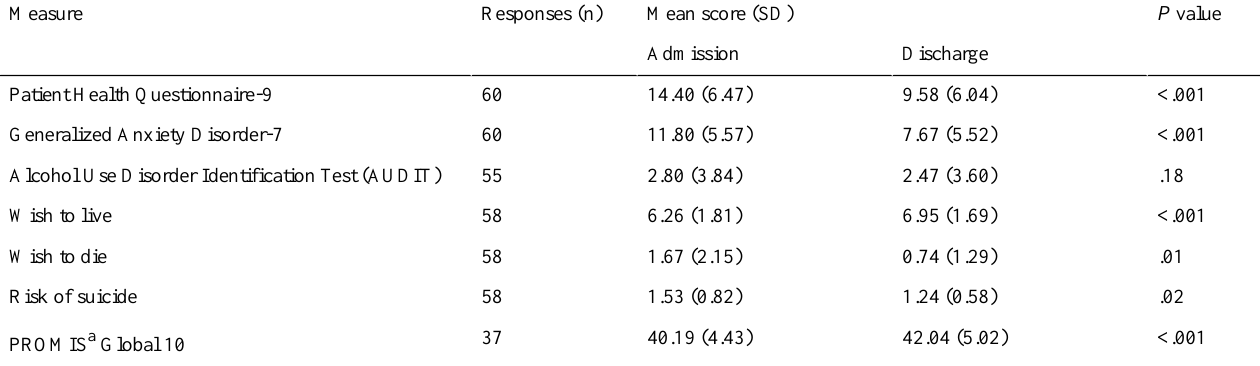
Table 2. Changes in standardized patient reported outcome measures from admission to discharge